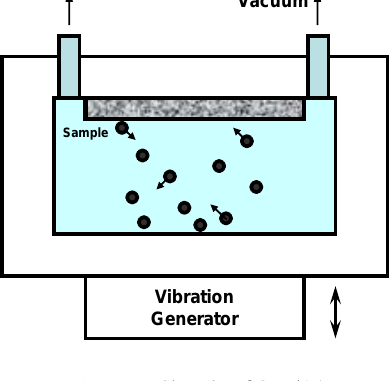
Figure 4: Sketch of